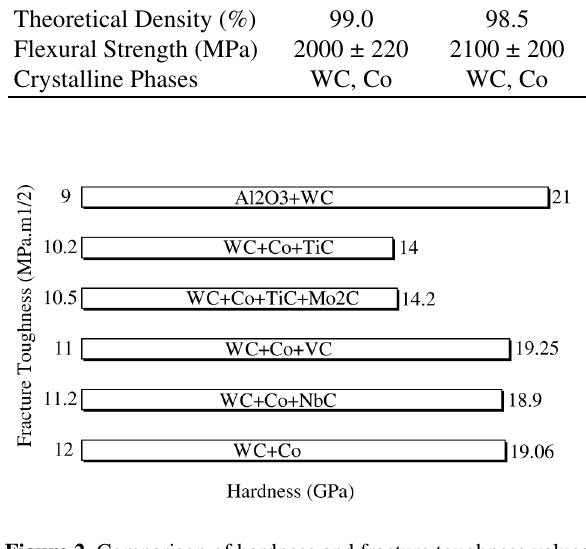
Figure 1. Mechanical properties of WC-Co with TaC-NbC 11 . Figure 2. Comparison of hardness and fracture toughness values from various different WC-materials 2-6,8,14